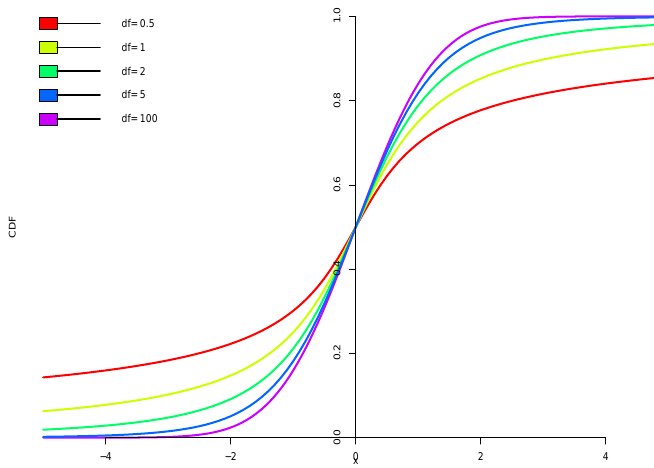
Figure 1. CDF of student- t distribution depending on degrees of